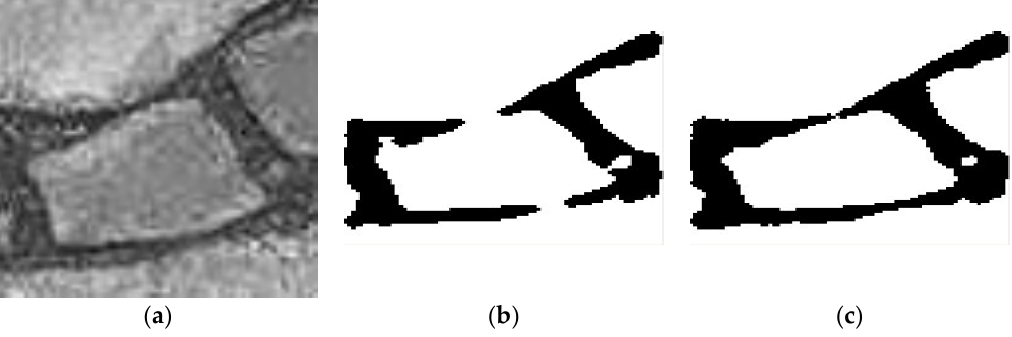
Figure 7. Morphological operations: ( a ) a gray-scale image; ( b ) after threshold; ( c ) watershed splitting filter with erosion/dilation for the splitting of contacts.